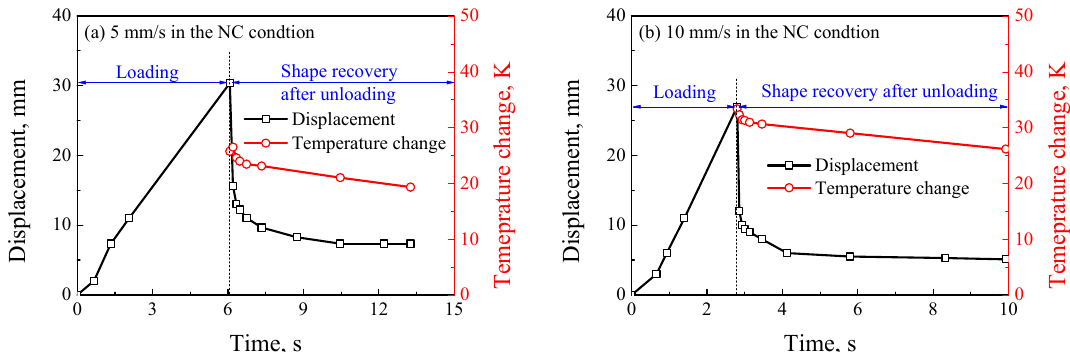
Figure 14. The curves of displacement and temperature change with time at the loading rates of ( a ) 5 mm/s and ( b ) 10 mm/s in the NC condition.